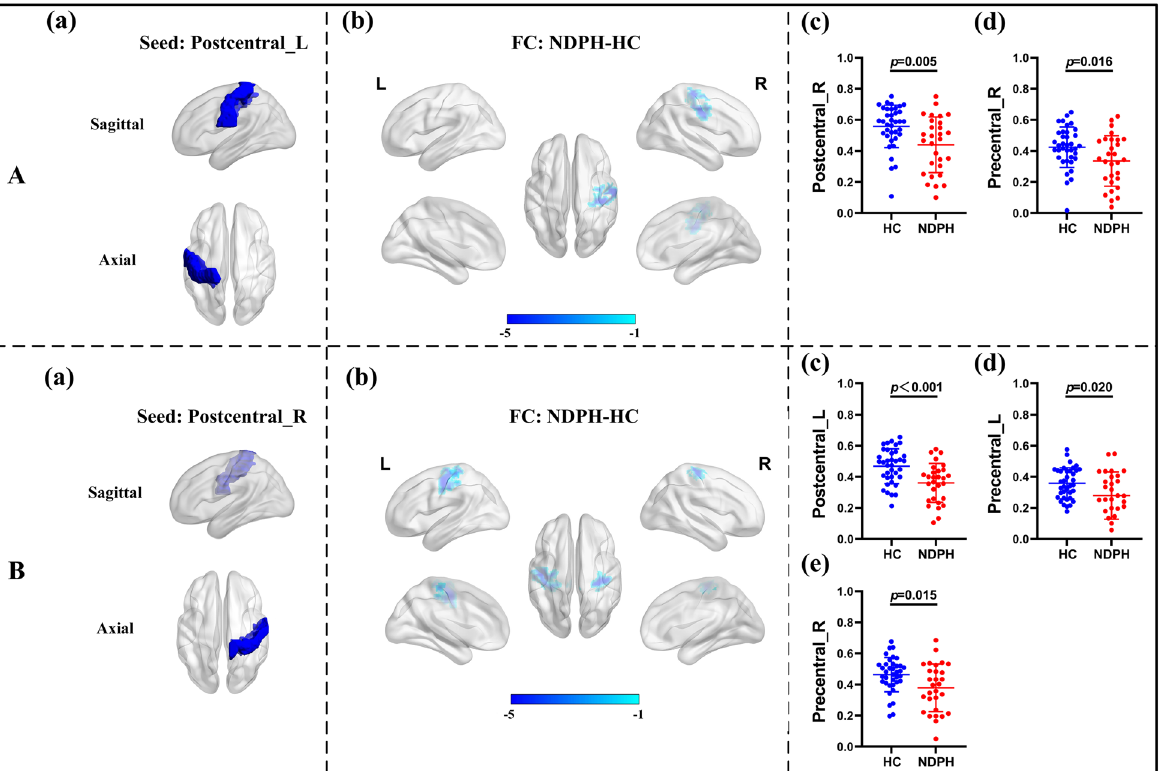
Fig. 4 FC analysis from bilateral postcentral gyrus to the whole brain voxels in NDPH and HC groups. A (a) The schematic diagram of the seed (left postcentral gyrus). (b) Compared with HCs, patients with NDPH showed significantly decreased FC between the seed and right postcentral gyrus, right precentral gyrus. (c) and (d) represented FC values between the seed and right postcentral gyrus, right precentral gyrus respectively in HC group and patients with NDPH. B (a) The schematic diagram of the seed (right postcentral gyrus). (b) Compared with HCs, patients with NDPH showed significantly decreased FC between the seed and bilateral precentral gyrus and left postcentral gyrus. (c) to (e) represented FC values between the seed and bilateral precentral gyrus and left postcentral gyrus respectively in HC group and patients with NDPH. Notes: The color bar showed t-values of the two-sample t-tests on FC. Abbreviations: L, left; R, right; FC, functional connectivity; NDPH, new daily persistent headache; HC, health